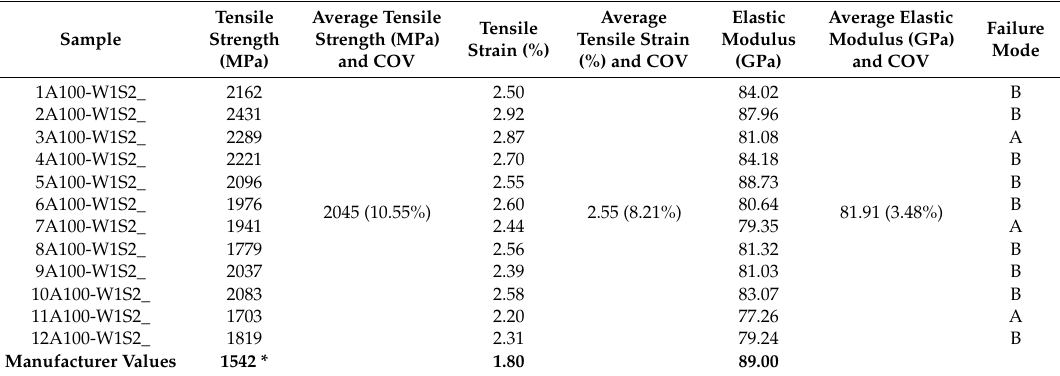
Table 4. Results of the basalt grid strips tested with a video-extensometer.